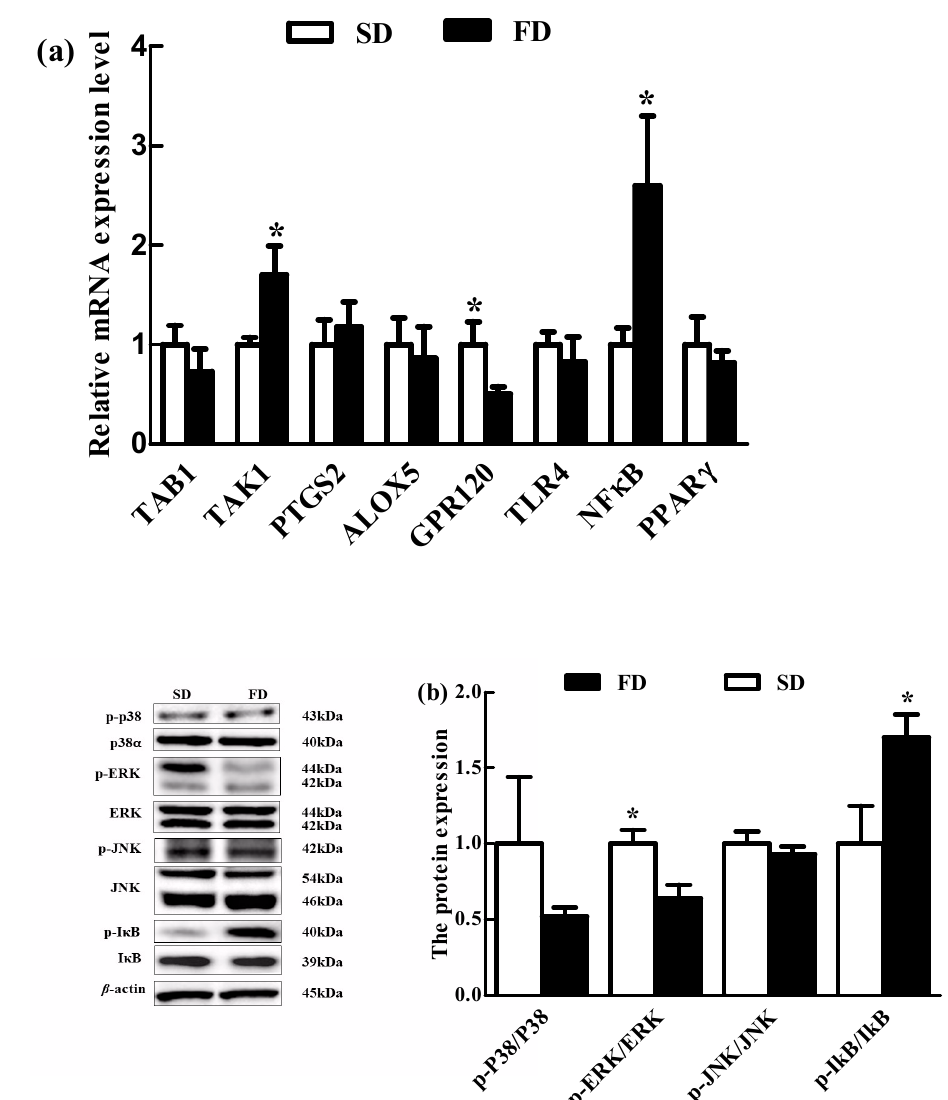
Figure 3. Effect of maternal diet with fish oil on mechanism parameters in the livers of piglets post-LPS challenged. ( a ) the expression of TAB1, TAK1, PTGS2, ALOX5, GPR120, TLR4, NF- κ B and PPAR γ mRNA in the livers of piglets from sows fed different diets were detected by quantitative fluorescence PCR. ( b )Western blotting method was used to detect the expression of JNK, p-JNK, p38 α , p-p38, ERK1/2, as well as phosphorylated p-ERK1/2, I κ B α and p-I κ B α protein in the livers of piglets from sows fed different diets. These values were expressed as the ratio of phosphorylated p-JNK, p-p38, p-ERK1/2 and P-I κ B protein levels to JNK, p38, ERK1/2 and I κ B protein levels. Values are means ( n = 4), with their standard errors represented by vertical bars. * Mean values were significantly different between the two diet groups ( p < 0.05). SD = soybean oil diet, FD = fish oil diet.